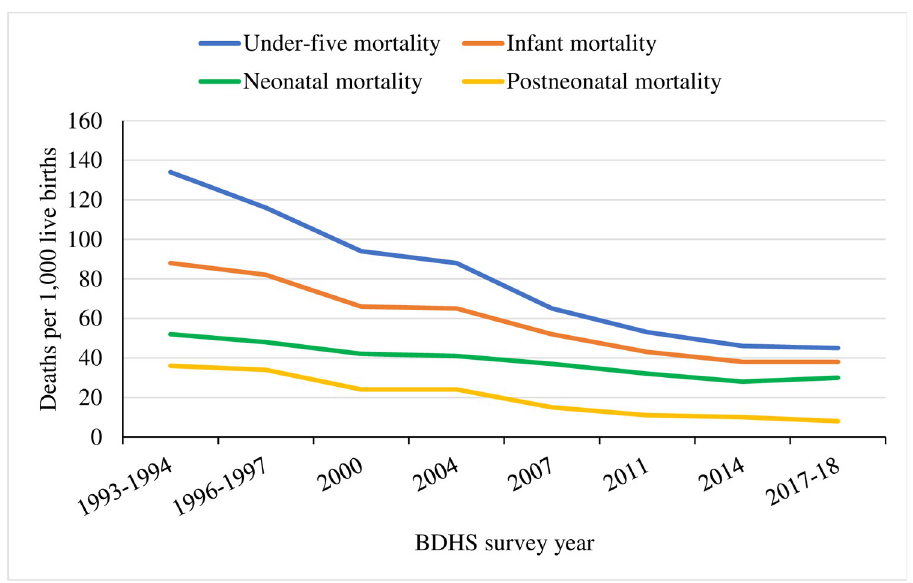
Fig 1. Trend of mortality rates of different groups of children from 1993 to 2018, Bangladesh. https://doi.org/10.1371/journal.pone.0262927.g001 Age of a child has been identified as a significant determinant of diarrhea. Therefore, to see a clear picture of the prevalence of diarrhea among under-5 children, Fig 2 illustrates diarrhea prevalence by age of a child and whether their mothers married as early age ( < 18 years old) or not. It is seen that the highest number of children suffer from diarrhea between the age of 12 to 23 months. However, after two years of age, the prevalence of diarrhea is declining for chil- dren whose mothers were getting married at an early age or not (Fig 2). Moreover, the Table 2. Prevalence of morbidity and mortality of under-5 years children by child marriage ( < 18 years) and adult marriage ( > = 18 years) in Bangladesh, BDHS- 2017/18. Morbidity and Mortality Indicators Labels Age of women at first marriage P-value < 18 Years > = 18 years n % n